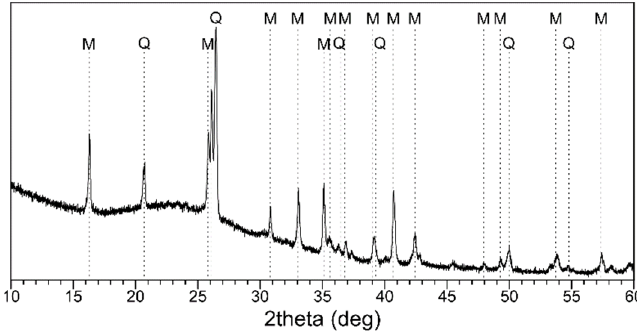
Figure 1. The XRD pattern of fly ash (M—mullite; Q—quartz).